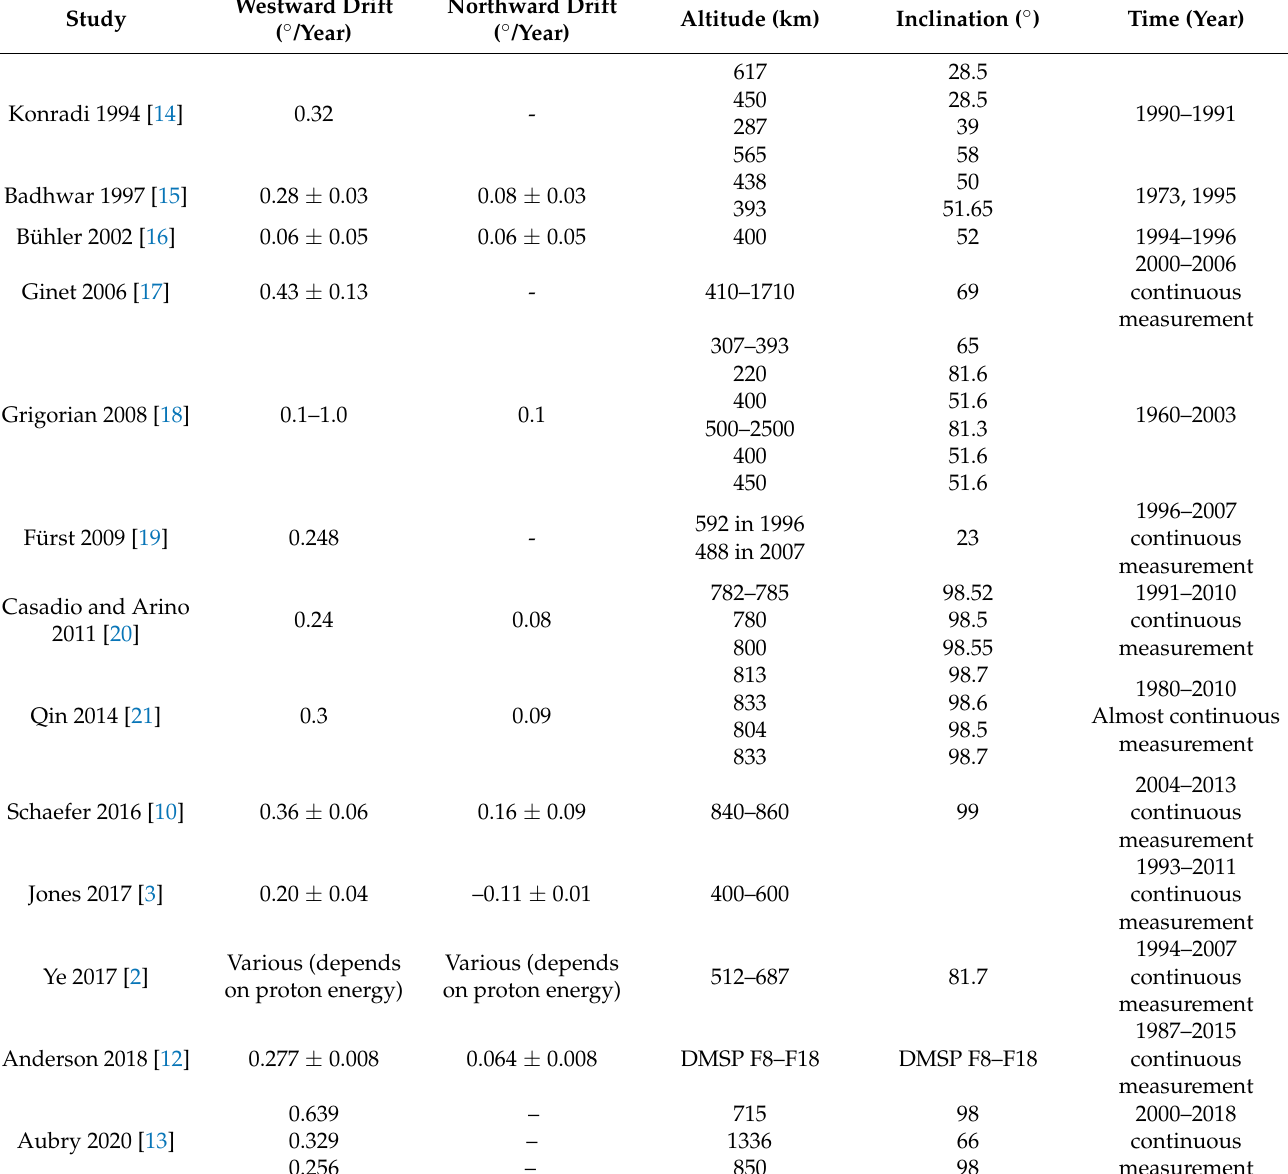
Table 1. Summarized results of measured South Atlantic Anomaly (SAA) drift